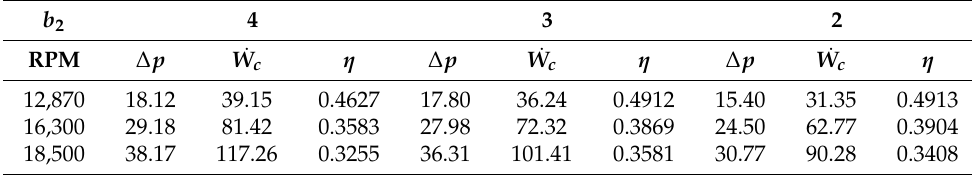
Table 11. Impeller outlet width sensitivity